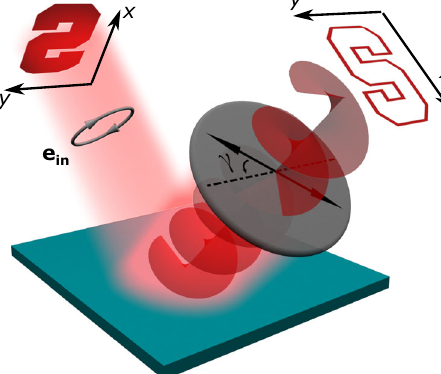
Fig. 1 Schematic of the experimental setup, where an incident beam with polarization e in is re fl ected by an interface, and then passes through a polarizer which selects a linear polarization with an orientation angle γ . This setup performs an isotropic two-dimensional spatial differentiation, and can generate an output beam with an orbital angular momentum of ±1 with an input Gaussian beam. x and y are the beam pro fi le coordinates for the incident and re fl ected light, which share the same origin on the